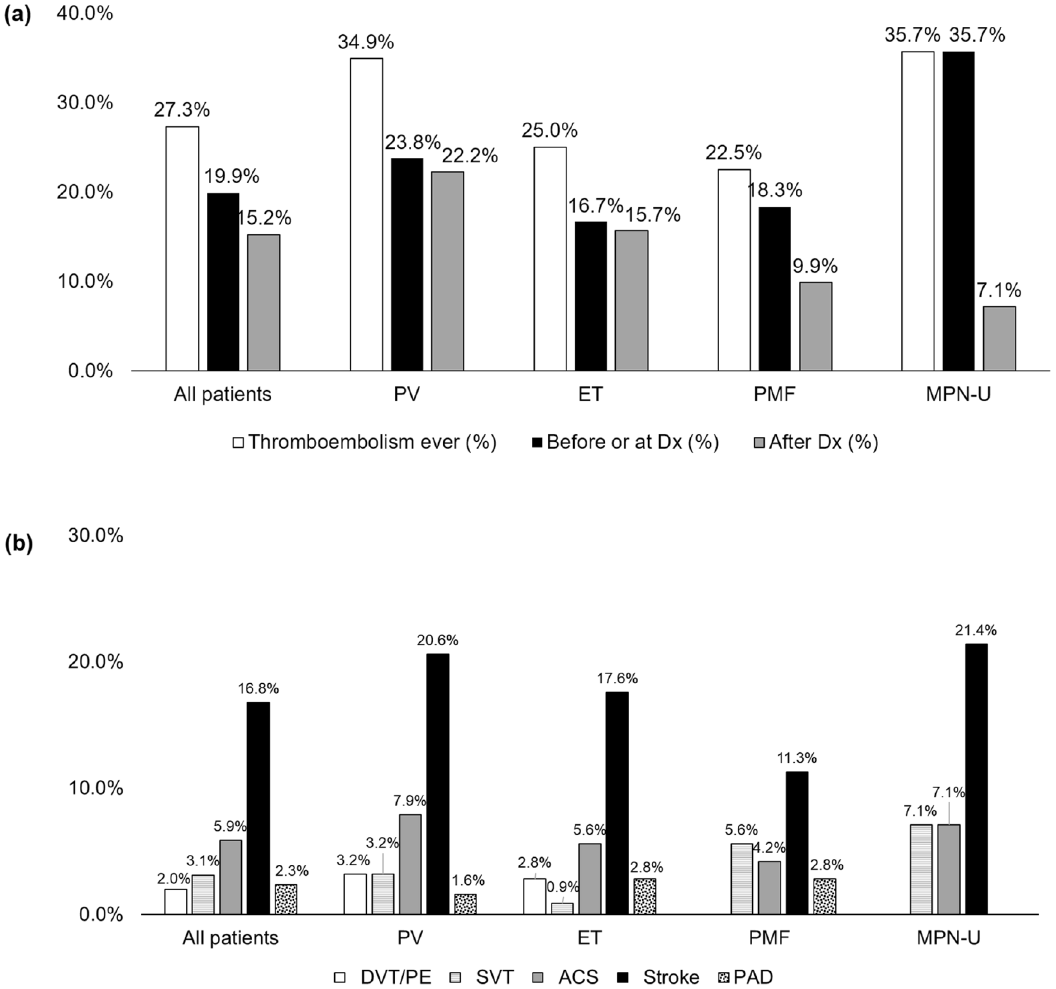
Figure 1. Overview of thromboembolic events in Korean myeloproliferative neoplasm (MPN) patients. ( a ) Per time point by MPN subtypes. ( b ) Site of thromboembolic events by MPN